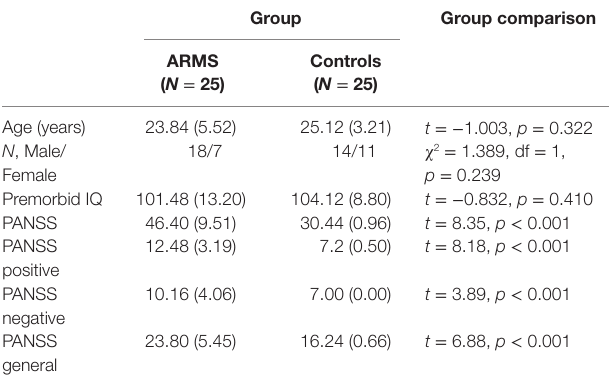
TaBle 1 | Demographic and clinical variables by